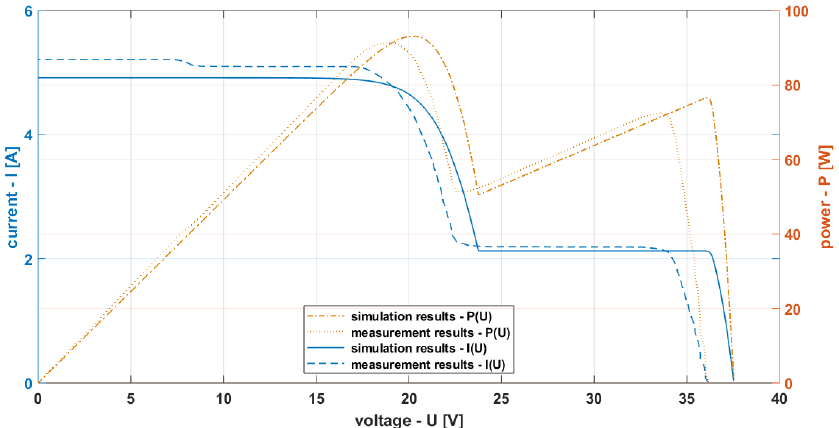
Figure 9. I–V characteristics of PV module MonoSol 260 EX made with partial shading. For detailed comparison of measurement and simulation results, see Table 2. Marking of measurement point M1 (two PV cells were shaded; the exact measurement time was 11:08 a.m.).